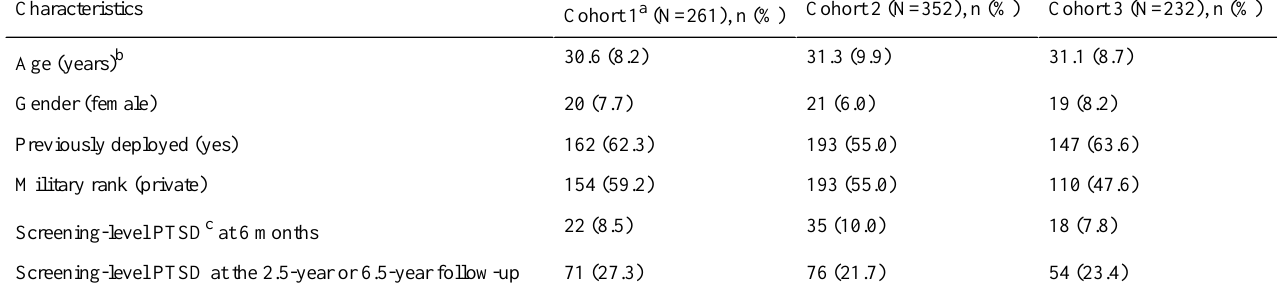
Table 1. Descriptive statistics of the 3